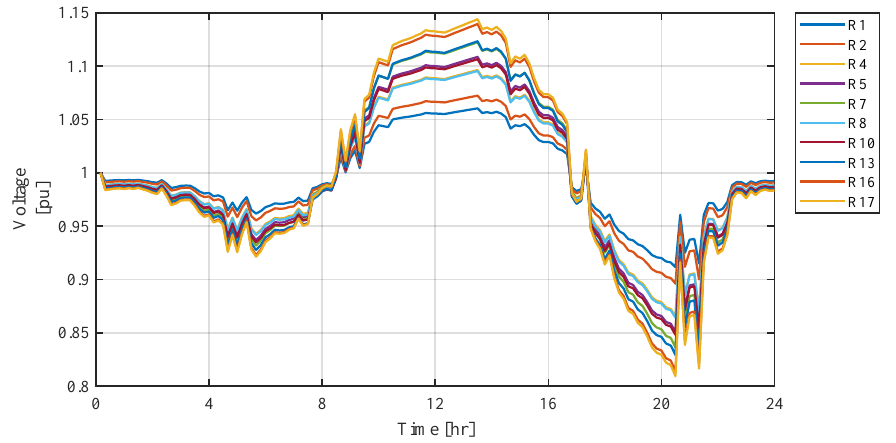
Figure 5. Plot of node voltages without battery energy storage systems (BESS) connected to the LV grid.